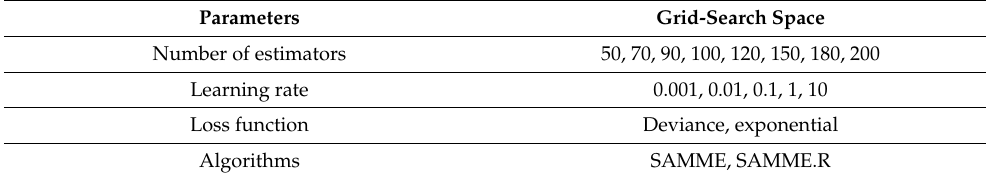
Table 3. GridSearchCV search space values for classifier hyperparameter tuning.